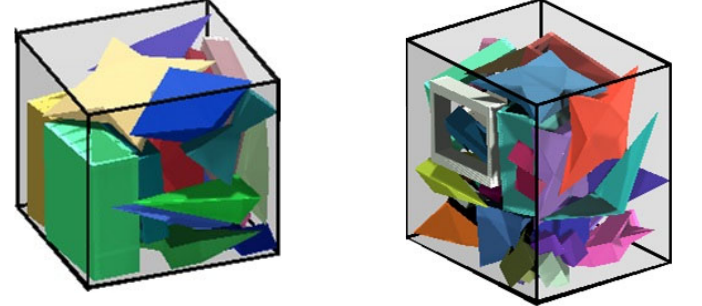
Fig. 23. Best solution obtained of the instance SGPS04